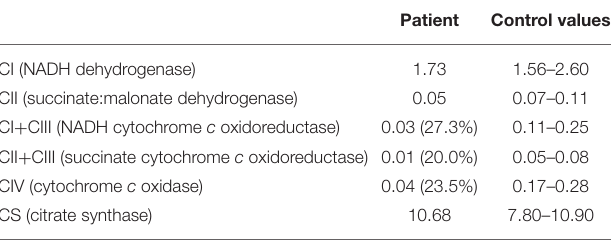
TABLE 1 | Respiratory chain enzyme activities in muscle homogenate.